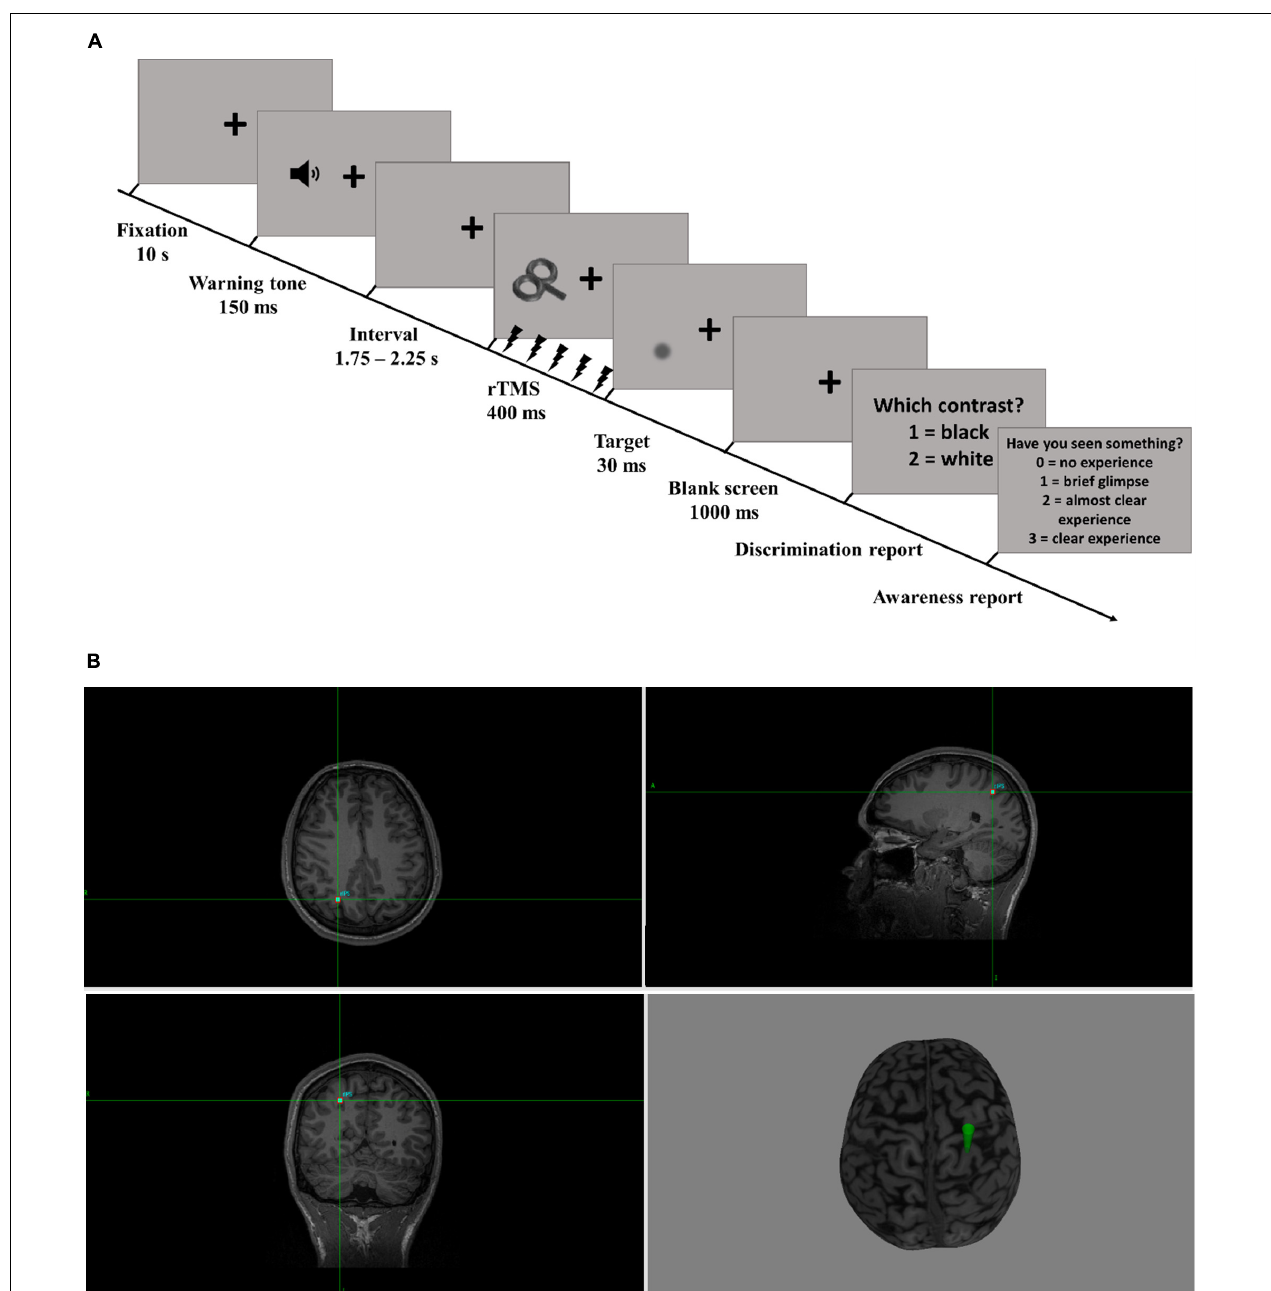
FIGURE 1 | Task design. (A) Trial time course. The trials started with the presentation of a fixation cross for 10 s. A tone warned participants that the target stimulus would be presented shortly. After an interval ranging from 1.75 to 2.25 s, rhythmic-TMS was applied in one of the three experimental conditions (rhythmic, arrhythmic, or sham). The target stimulus was presented at the end of the last TMS pulse for 30 ms. Participants were then prompted to indicate the stimulus luminance of the target relative to the background and rate their subjective perceptual experience on the PAS. (B) TMS target. This MR scan from a representative participant illustrates the target that was used for the neuro-navigation (right intraparietal cortex, rIPS). The TMS coil was oriented such that its handle was pointing upwards (R, Right; L, Left; A, Anterior; P, Posterior).